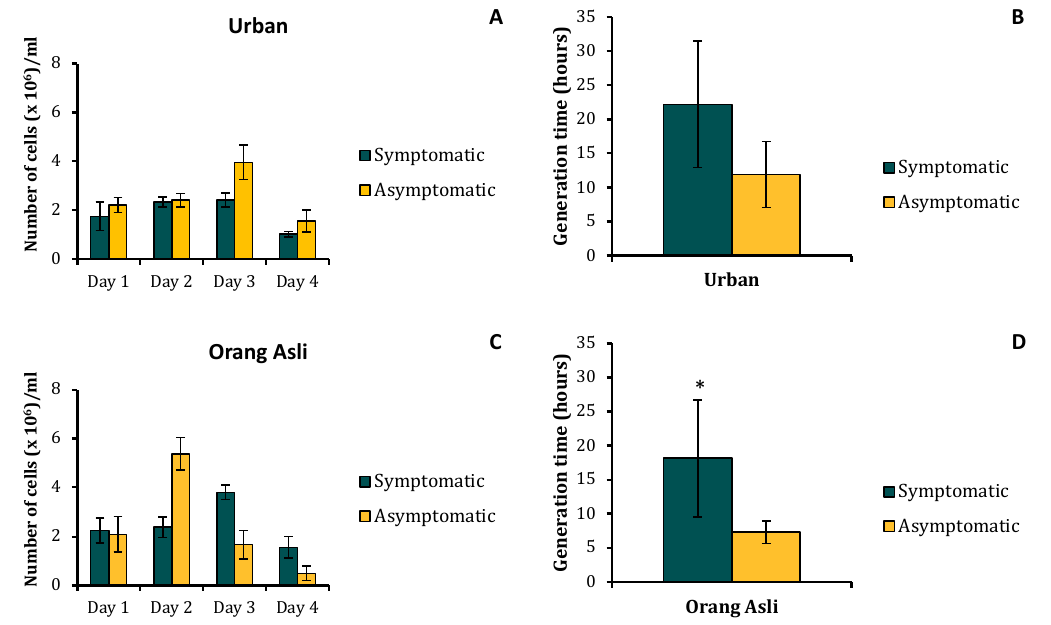
Figure 1. Growth profile of Blastocystis sp. isolated from urban and orang asli individuals ( A , C ) with their respective generation time ( B , D ). Viable cells were counted in 1 mL volume using the trypan blue exclusion test. Values are expressed as mean ± SD. * p < 0.05 for Students t -test.